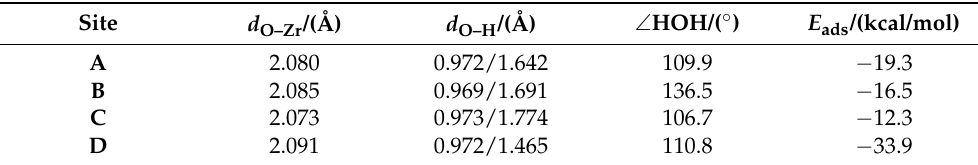
Table 3. Structural parameters and related energies of water dissociation on ZrO 2